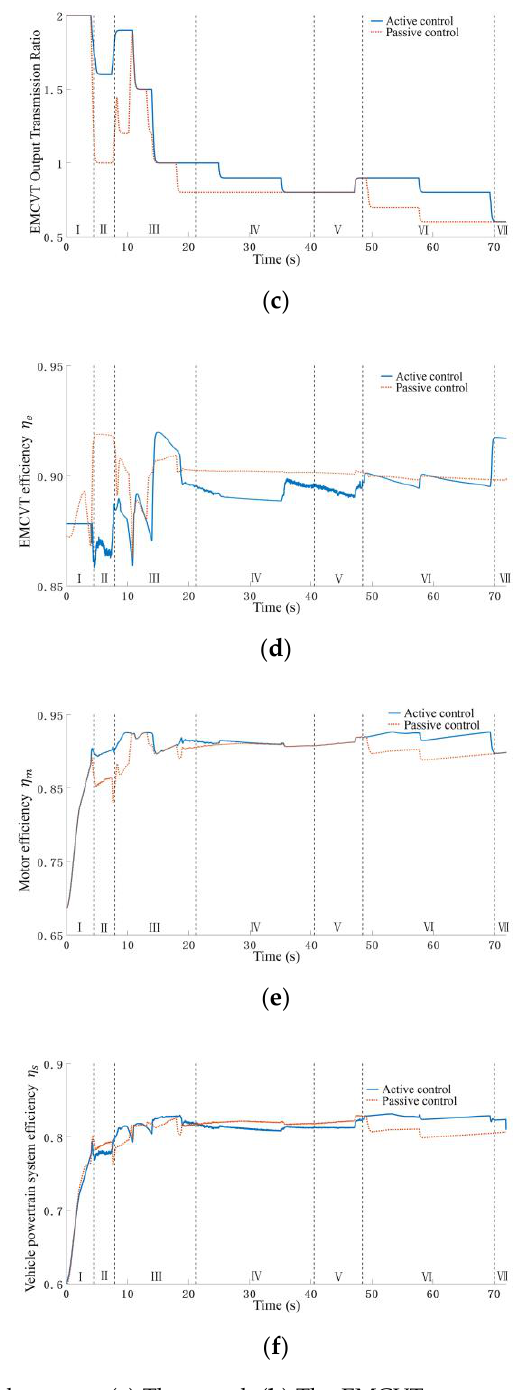
Figure 15. The test result curves: ( a ) The speed; ( b ) The EMCVT target transmission ratio; ( c ) The EMCVT output transmission ratio; ( d ) The EMCVT efficiency; ( e ) The motor efficiency; ( f ) The vehicle powertrain system efficiency.